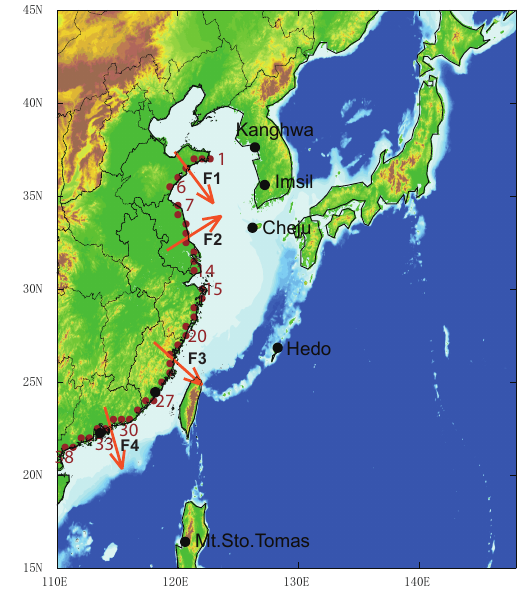
Figure 5. Map of the focused domain. The black dots are the lo- cations of nine EANET sites that used for model evaluation of ni- trogen deposition near the coast (Fig. 6): Mt. Sto. Tomas, Hedo, Cheju, Imsil, Kanghwa, Xiamen (Hongwen and Xiaoping sites), and Zhuhai (Xiang Zhou and Zhuxiandong sites). The red dots rep- resent the grid cells covering the coastline of mainland China that are used for determining the outflow fluxes as indicated by the or- ange